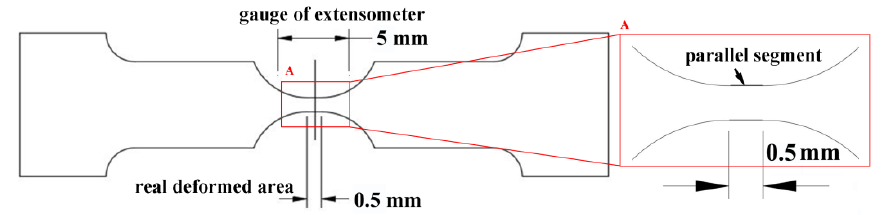
Figure 1. Schematic of the tensile specimen.